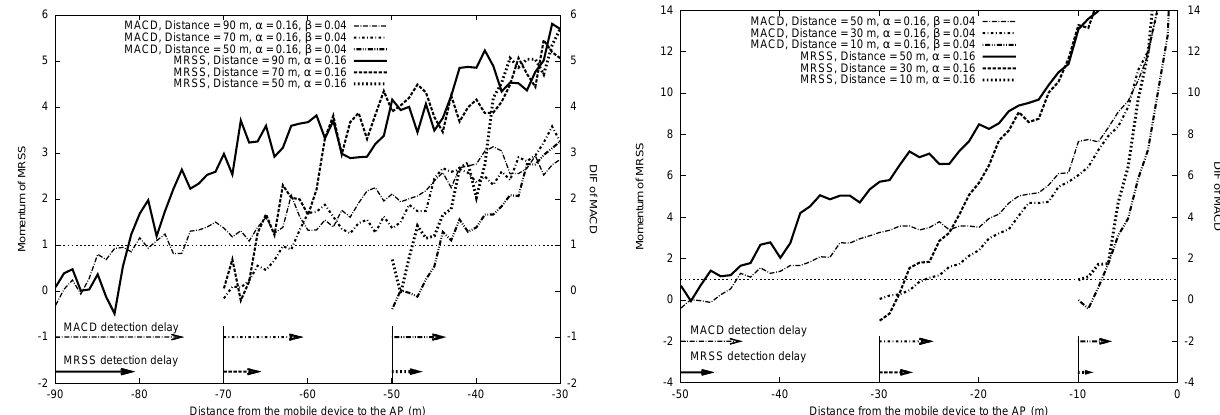
Figure 8. The effect of approaching movement in the WLAN environment.